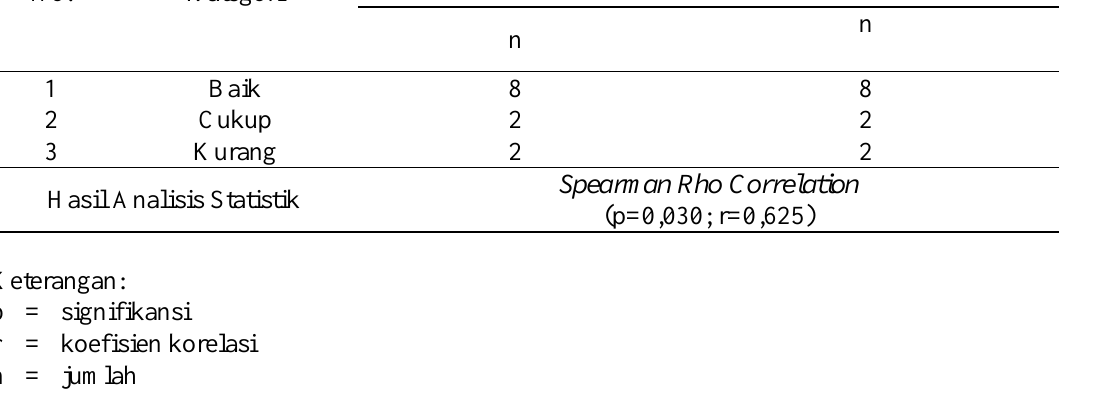
Tabel 2 Hubungan penerapan metode ABA dengan perkembangan interaksi sosial pada anak